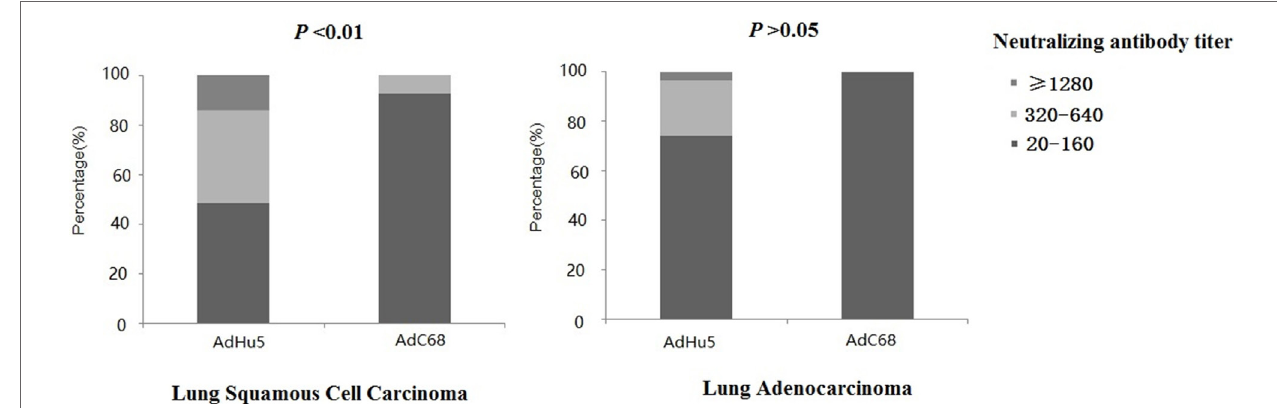
FigUre 3 | Distribution of AdHu5 and AdC68 neutralizing antibody (NAb) titers in positive samples from lung squamous cell carcinoma and adenocarcinoma subjects. NAb titers were stratified in the following tiers: low titer ( ≥ 20 and ≤ 160), medium titer ( ≥ 320 and ≤ 640), and high titer ( ≥ 1,280). For the positive samples from lung squamous cell carcinoma patients, the AdHu5 NAb titers from low to high were 48.28, 37.93, and 13.79%, respectively, while the AdC68 NAb titers from low to high were 92.86, 7.14, and 0%, respectively; this was significantly different from AdHu5 ( P < 0.05). For positive samples from lung adenocarcinoma patients, the AdHu5 NAb titers from low to high were 74.19, 22.58, and 3.23%, respectively, while all of the positive AdC68 NAb sample titers were lower or equal to 160. However, no significant difference in the distribution of the two vectors in lung adenocarcinoma patients was observed ( P > 0.05).